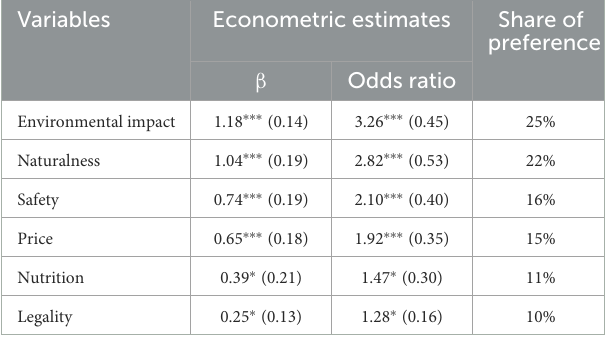
TABLE 5 Model estimation: beta coefficients and odds ratio for the most important (best) values. Variables